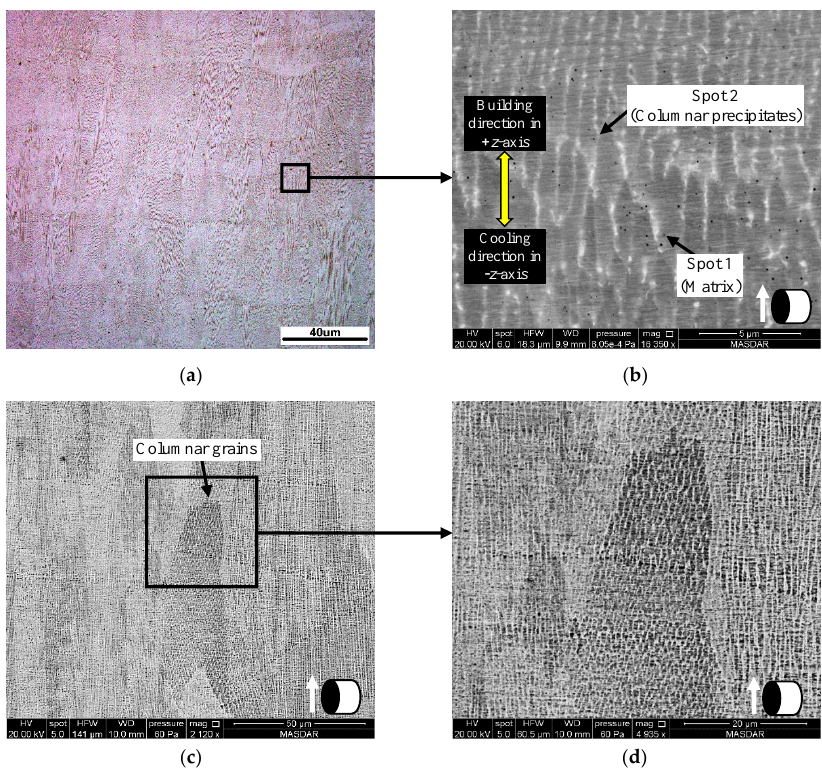
Figure 1. ( a ) Optical microscope images of the layer-by-layer structure of SLM process; ( b ) high magnification Scanning electron microscope (SEM) image of columnar micro-dendrites; ( c , d ) SEM micrographs showing a columnar grain continuously grew across the melting pool boundary.